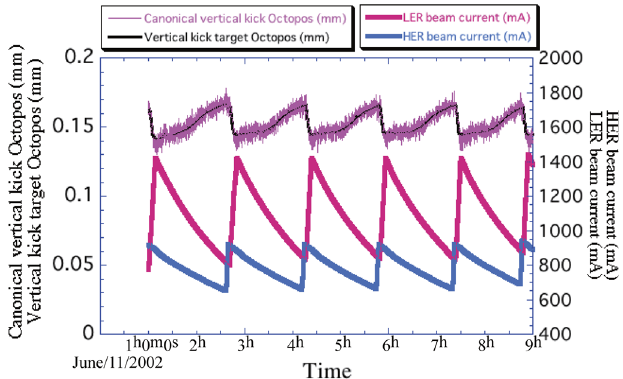
FIG. 9. (Color) Canonical vertical kick monitored by the OctoPos BPMs together with the feedback target value. The HER and LER beam currents are also